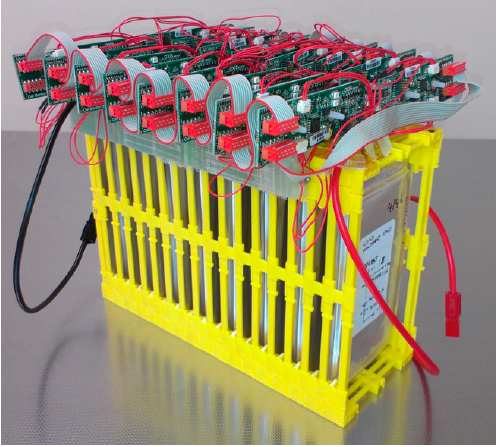
Figure 2. A 16-cell Li-S pack developed by OXIS Energy.